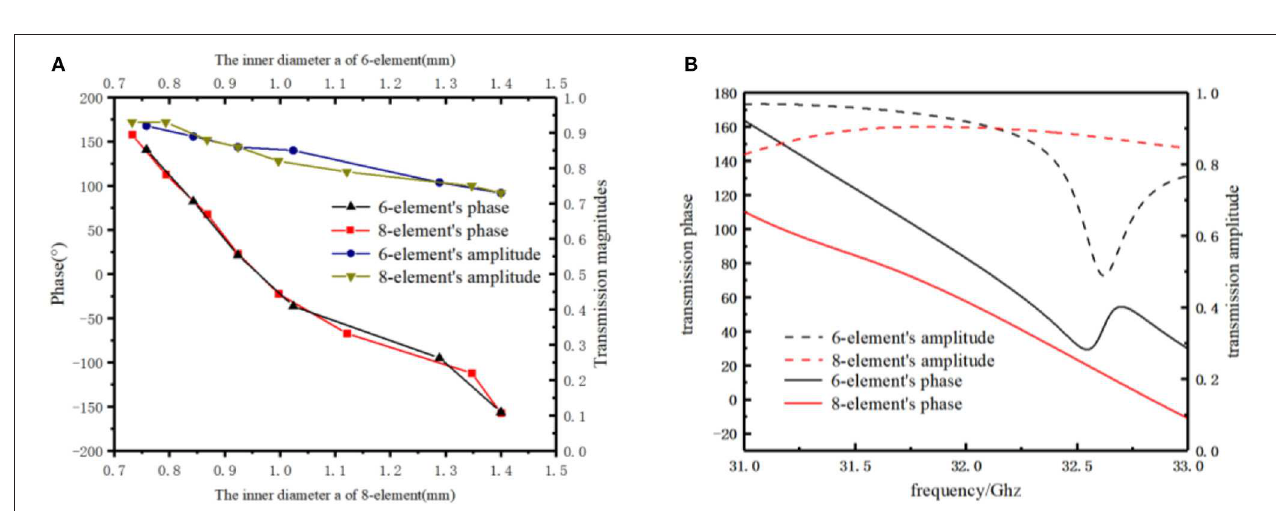
FIGURE 3 | (A) The transmission phase and magnitude of the 6-element and 8-element array varies with the inner diameter. (B) Parameters of the transmission varies with the frequency. phase of six-element and eight-element, respectively; the blue line marked with circle and the yellow marked with triangle represent the transmission amplitude of six-element and eight- element, respectively. The maximum range of the phase shift at 32 GHz can reach 315 ◦ , which is close to a full cycle and sufficient for the intended operation of transmission while maintaining the amplitude of the transparent microwave. The transmission amplitude of six-element and eight-element both decreases and are inversely proportional to a , but they are all larger than 0.7, and the maximum is 0.91 and 0.93, respectively. It means our model can deflect the transmission beam in good condition. In this is 5 mm. In the structure, we get the desired phase shift by just changing the inner radius parameter of the metallic patch. The phase from − 157 ◦ to 158 ◦ can be realized with the phase change